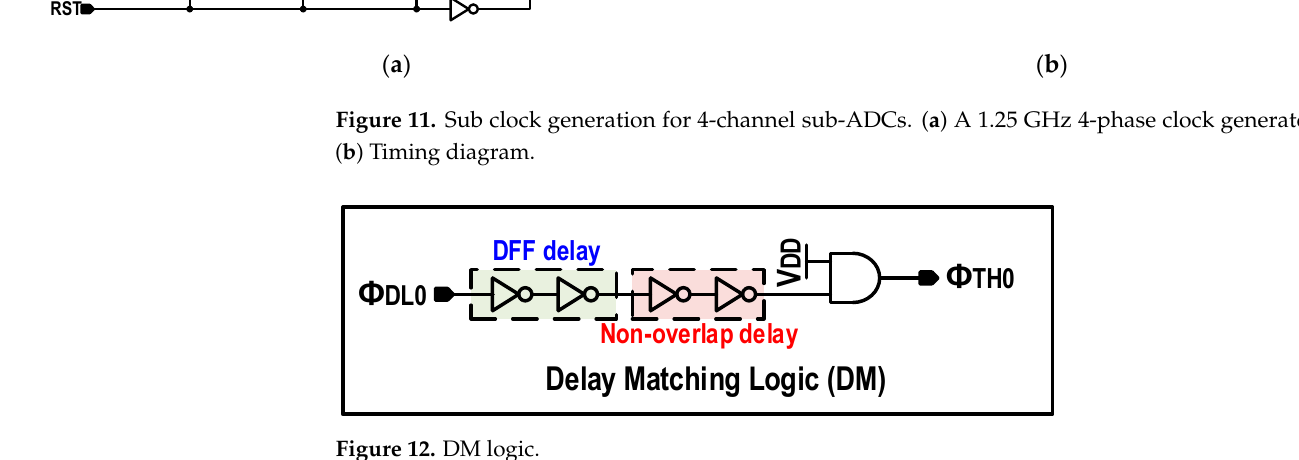
Figure 12. DM logic.